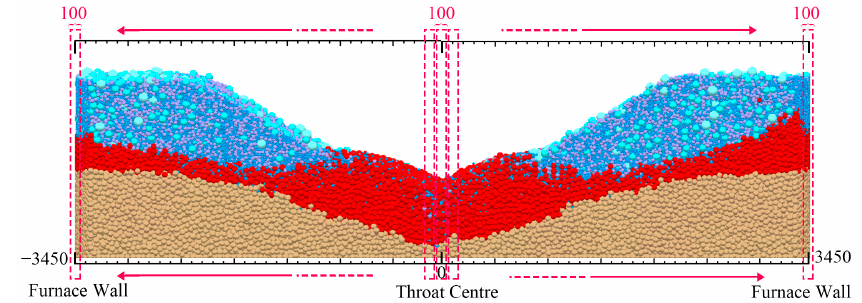
Figure 9. Schematic diagram of the delineated sampling area.